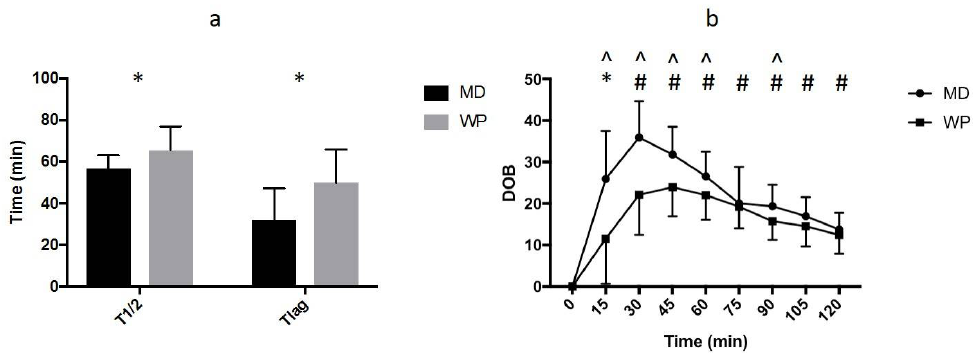
Figure 1. ( a ) Half emptying time (T 1/2 ) and time of maximum emptying rate (T lag ) (mins) during the maltodextrin (MD) and whey protein (WP) trials. “*” indicates a significant difference ( p < 0.050) between trials. ( b ) DOB values during the maltodextrin (MD) and whey protein (WP) trials. “*” indicates significantly elevated time points ( p < 0.05) from pre-ingestion for the MD trial, “#” indicates significantly elevated time points ( p < 0.050) from pre-ingestion for the MD and WP trials and “^” indicates a significant difference ( p < 0.050) between the MD and WP trials at a time point.